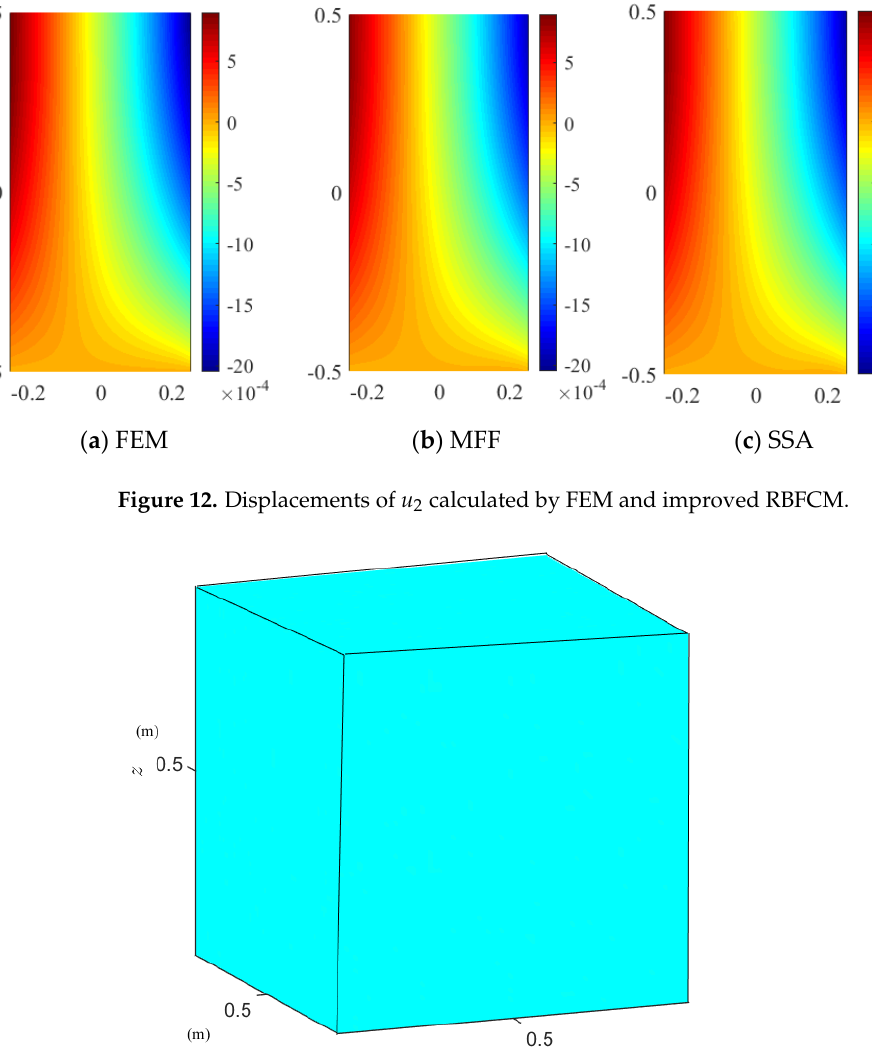
Figure 12. Displacements of u 2 calculated by FEM and improved RBFCM.